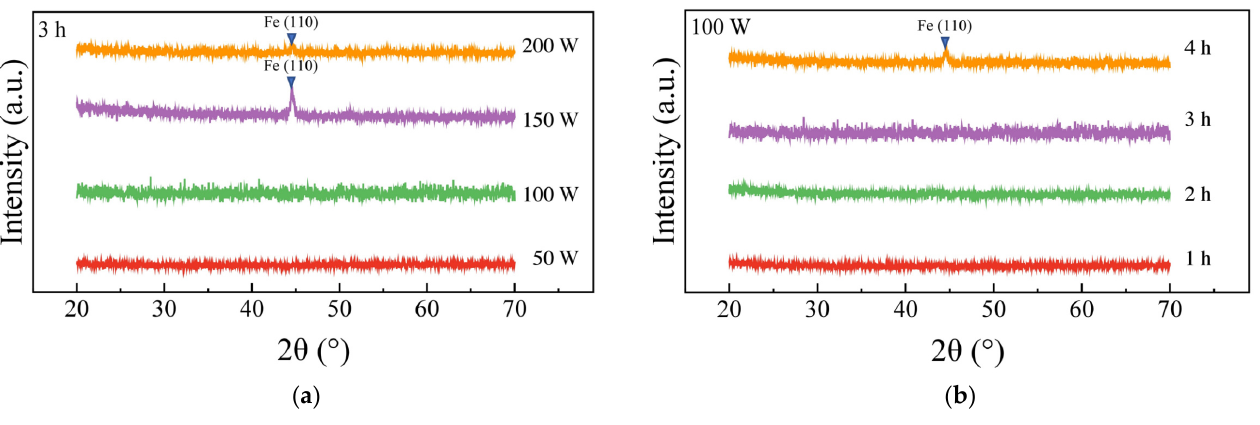
Figure 2. XRD patterns of TbDyFe films obtained at different ( a ) sputtering powers (50 W, 100 W, 150 W, and 200 W) and ( b ) deposition times (1 h, 2 h, 3 h, and 4 h). Table 2. The grain size of Fe in the TbDyFe films calculated from the diffraction angle and FWHM.